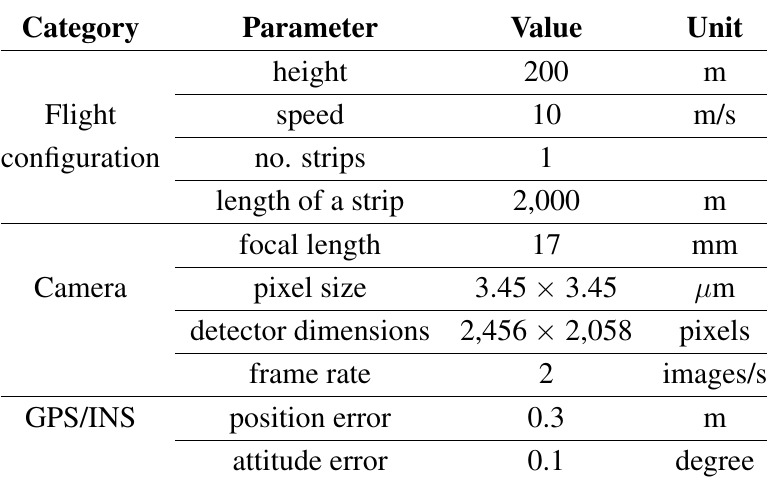
Table 2. Main simulation parameters.